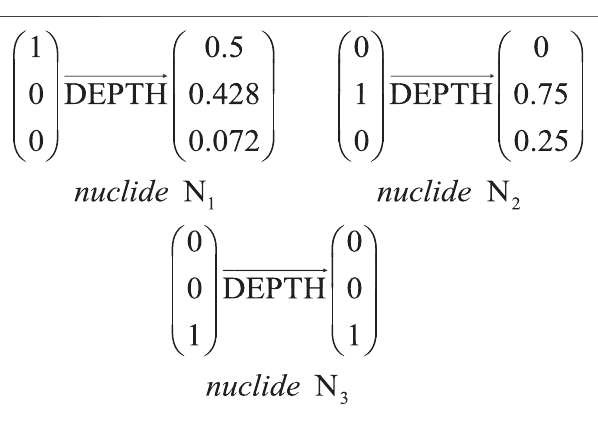
FIGURE 2 | Solution process using three unit orthogonal